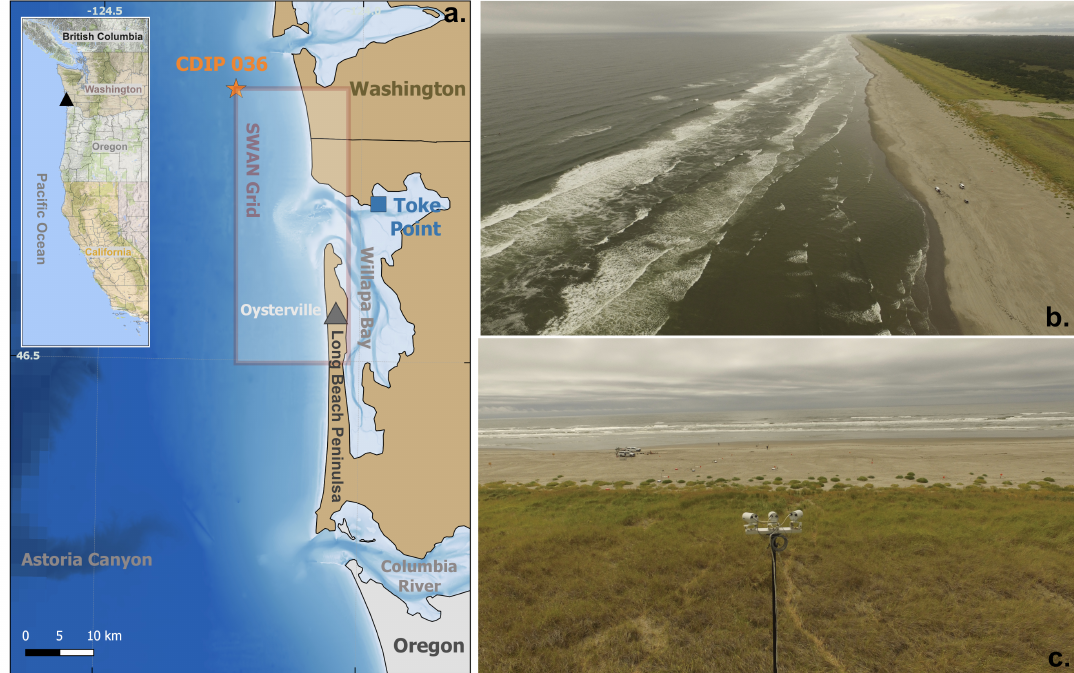
Figure 3. ( a ) Map of the Oysterville field site on the Long Beach Peninsula, WA, USA. The locations of nearby wave (Coastal Data Information Program (CDIP) 036), tide (Toke Point, WA), and wind measurements (Toke Point, WA) and the Simulating Waves Nearshore (SWAN) wave model domain used to transform offshore waves locally to Oysterville are also shown. ( b , c ) Aerial photos of nearshore, beach, and dune at Oysterville, WA taken on 9 August 2016 during low energy wave conditions (H s ∼ 1.5 m). Photo ( c ) is taken from directly above the foredune crest where a camera mast system (shown) and meteorological station (not shown) were located during SEDEX 2